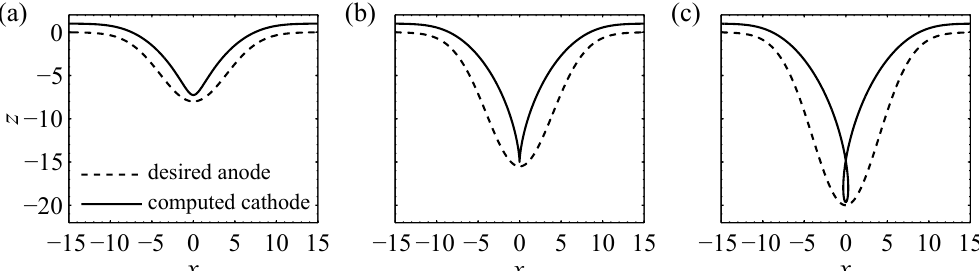
Figure 3. Cathode shapes (solid lines) required to produce Gaussian anode shapes (dashed lines) defined by Equation (17) with σ = 4 (spatial dimensions are normalized to the width of the standard equilibrium front gap). The solutions in parametric form are given by Equations (18) and (19). The scale on the z -axis and the legend of Panel ( a ) apply for all three panels. Panel ( a ) shows the example with A = 8 < A ∗ = 15.51, resulting in a regular cathode shape. Panel ( b ) shows the anode with A = A ∗ = 15.51 (see Equation (20) in the text), for which, the computed cathode is singular and represents the limit of physically realizable cathode shapes. Panel ( c ) shows a non-physical solution to a cathode shape obtained for a Gaussian anode with A =